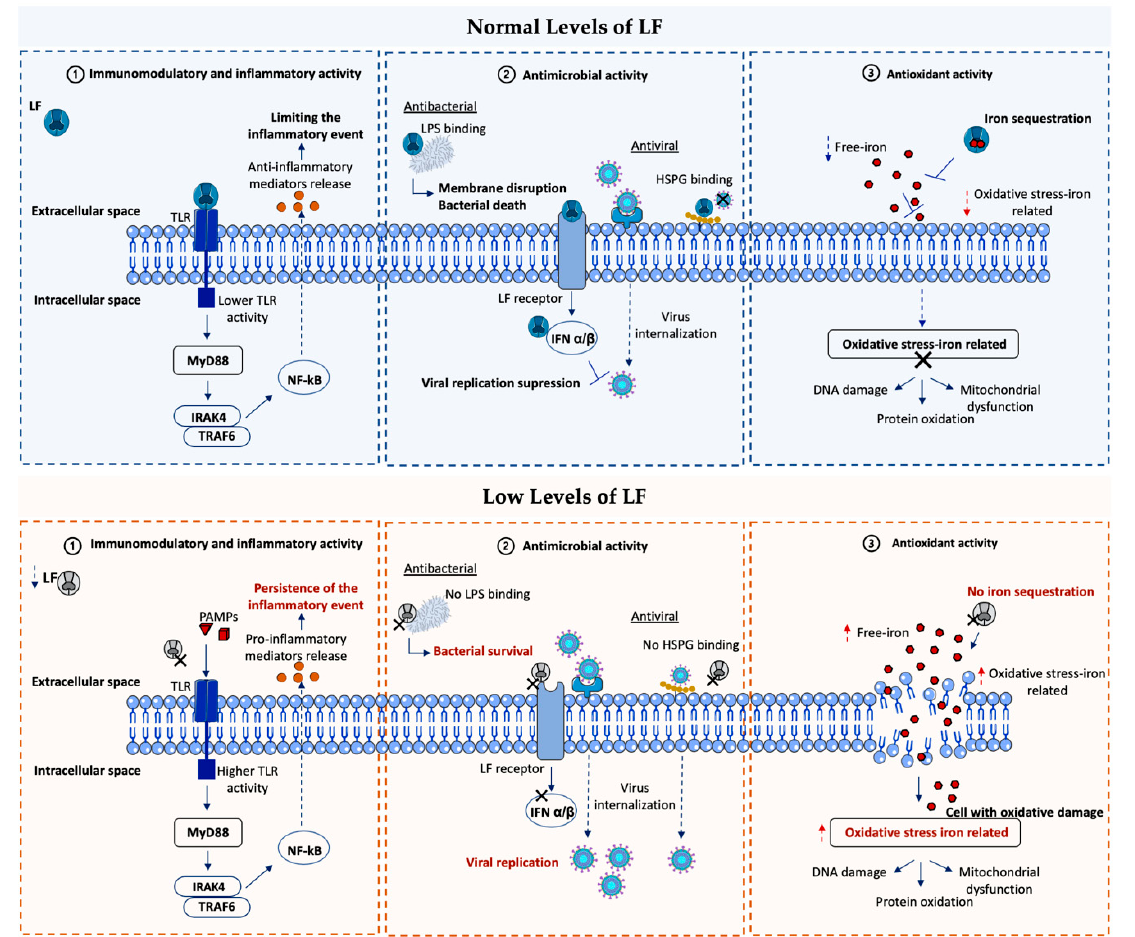
Figure 4. LF-signaling pathways involved in mechanisms leading to major OSDs. (1) About OSDs associated with immune–inflammatory events (such as keratoconus or dry eye), LF modulates